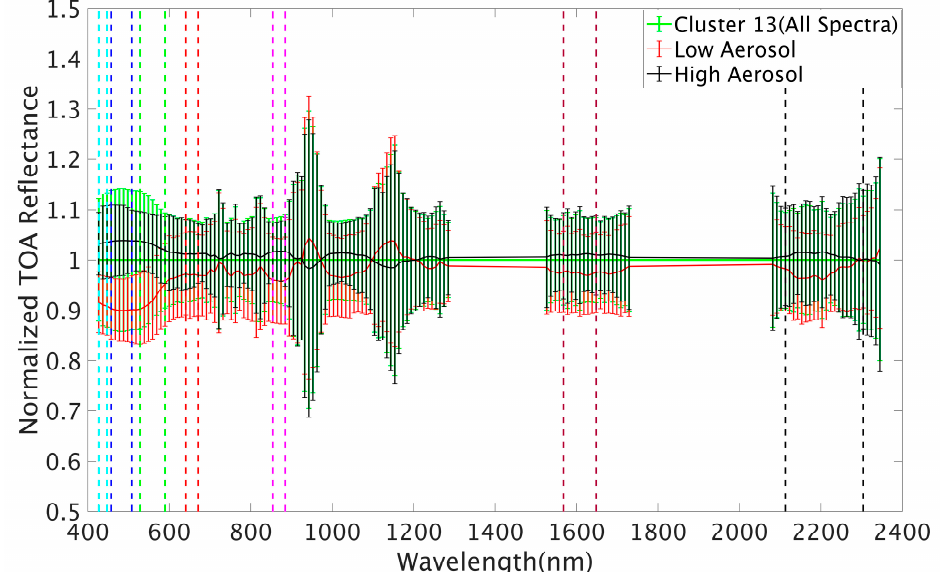
Figure 14. Comparison of the representative hyperspectral profile of Cluster 13 with the hyperspectral measurements corresponding to low and high aerosol concentration. The green curve represents the normalized hyperspectral profile of Cluster 13. The red curve represents the hyperspectral spectral corresponds to low aerosol concentration higher water vapor content whereas and the black curve represents the hyperspectral spectrum corresponds to higher aerosol concentration (error bars = 2 sigma).